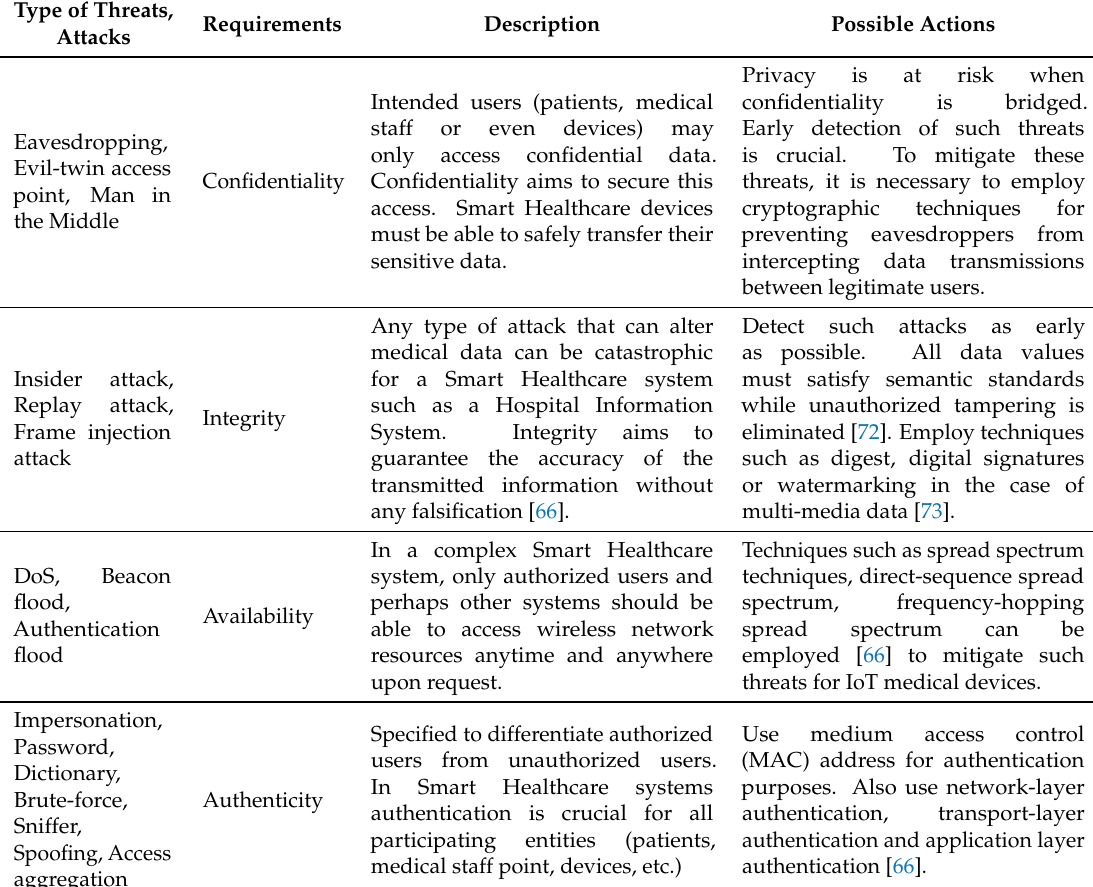
Table 3. Security and Privacy–Threats and Actions for Smart Healthcare